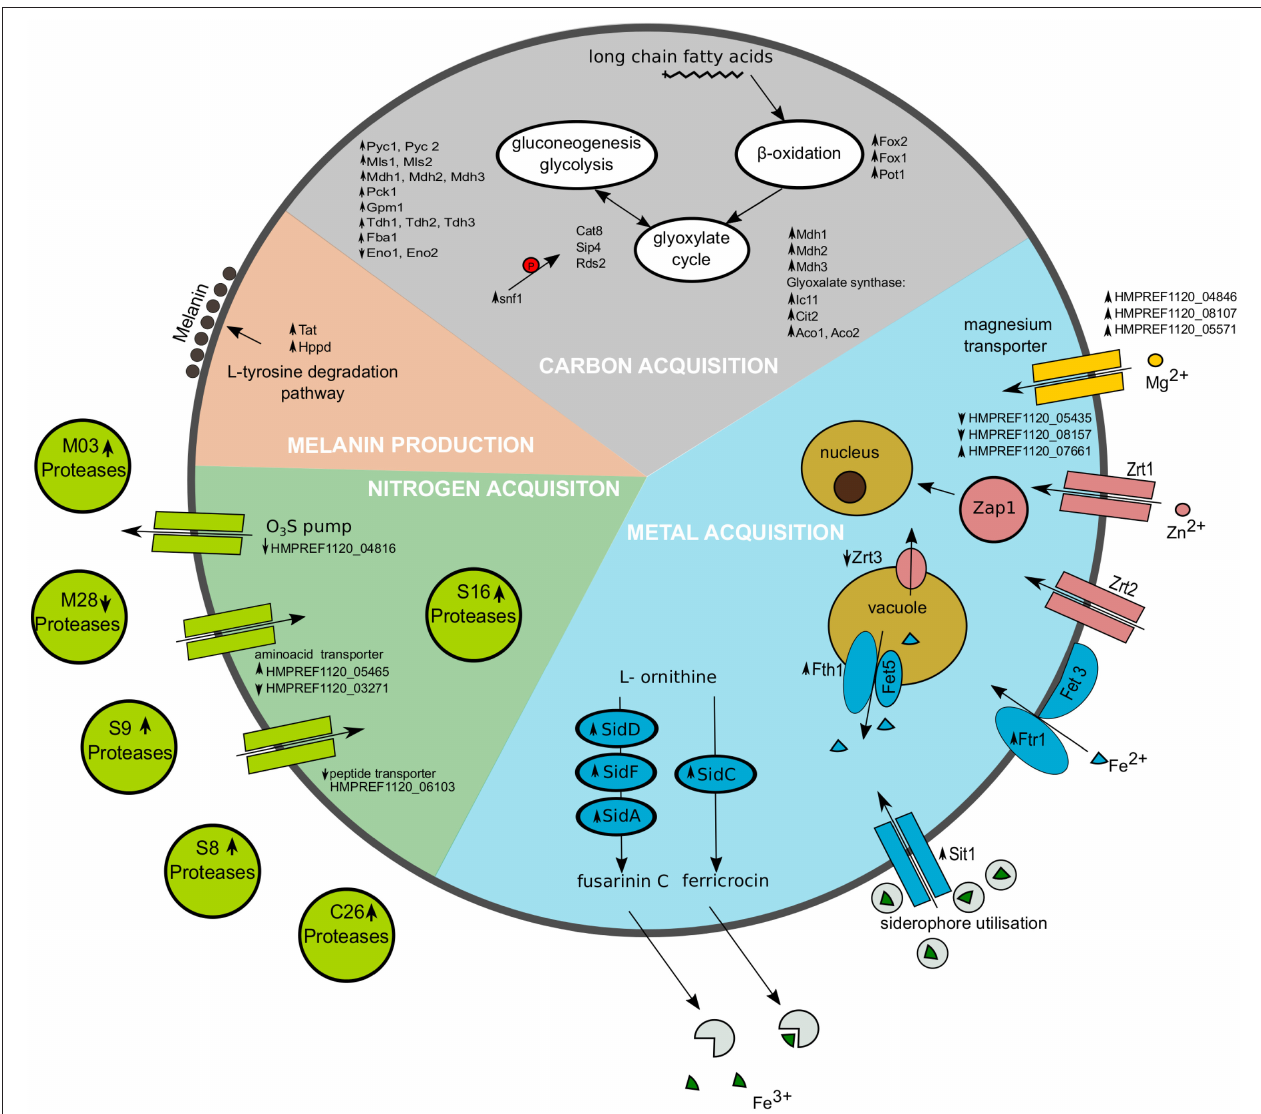
FIGURE 5 | Representation of selected cellular processes significantly regulated in Exophiala dermatitidis when growing on skin. Metal acquisition is shown in the blue region, Nitrogen acquisition in the green region and carbon acquisition in the gray region. Melanin production is found in the salmon pink region. Upregulated genes are marked with upward pointing arrows, while downregulated genes are marked with downward pointing arrows. The red P in the carbon acquisition part indicates